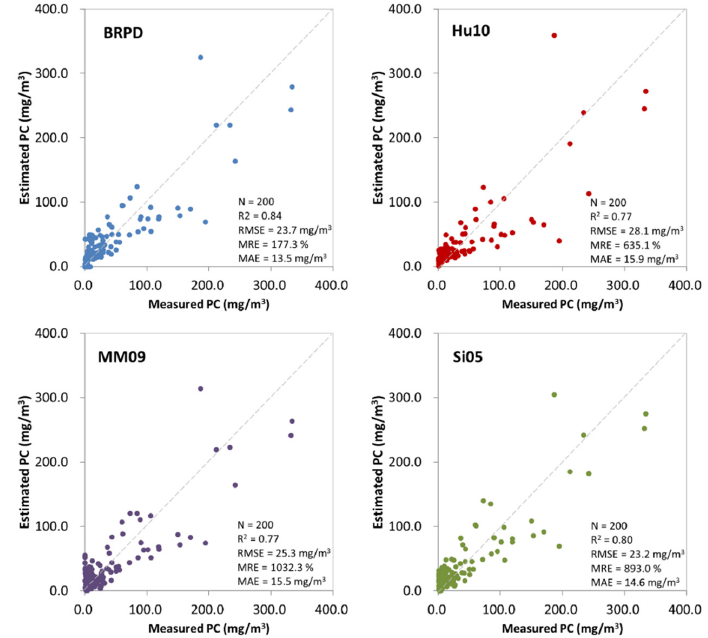
Figure 5. Results of applying four different algorithms to the calibration datasets. BRPD performed better than the other three methods in all of the error indices except RMSE, which was slightly higher than the Si05 value.